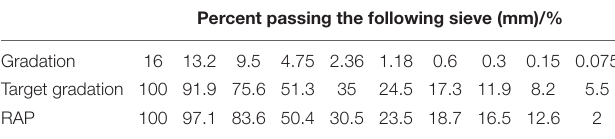
TABLE 1 | AC-13 asphalt mixture gradation.